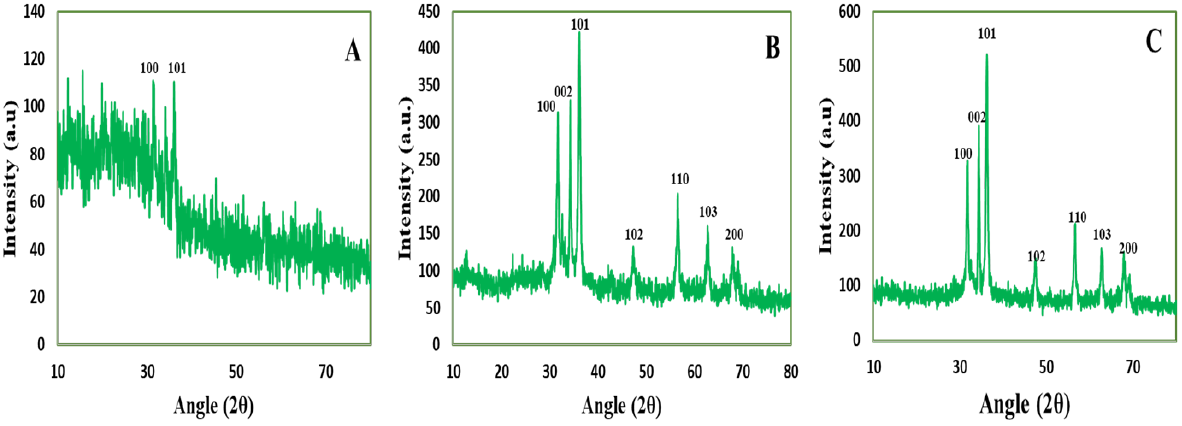
Figure 5. XRD patterns of ZnONPs ( A ) CE-ZnONPs ( B ) CE-UV-A-ZnONPs and ( C ) CE-UV-C-ZnONPs.